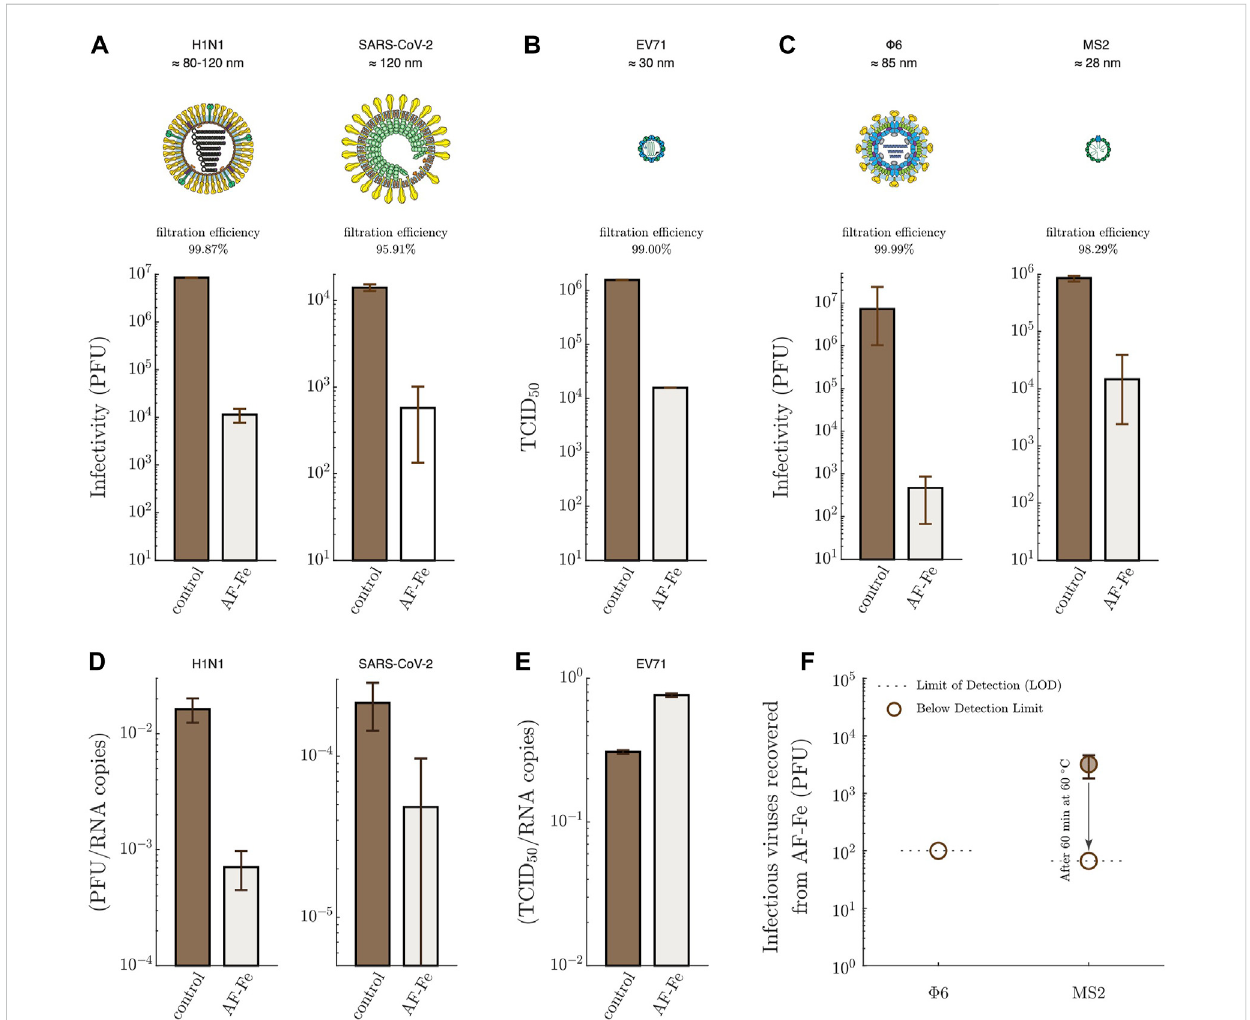
FIGURE 3 Filtration of virus-loaded aerosols using AF-Fe. Infectious viruses trapped on the gelatine membranes in the absence (control) and the presence of AF-Fe for H1N1 and SARS-CoV-2 (A) ; EV71 (B) ; Φ 6 and MS2 (C) . The plotted values for H1N1 (control and AF-Fe), SARS-CoV-2 (control and AF-Fe), EV71 (control and AF-Fe), and Φ 6 (AF-Fe) represent the average from two replicas, with the error bars representing the range. For Φ 6 (control) and MS2 (control), the plotted values represent the average from four replicas, with the error bars representing the range. For MS2 (AF-Fe), the plotted value representstheaveragefromthreereplicas,withtheerrorbarrepresentingtherange.ForH1N1,SARS-CoV-2, Φ 6,andMS2,theinfectivitywasdetermined using plaque-forming units (PFU) assays. The infectivity of EV71 was determined using median tissue culture infectious dose (TCID 50 ). The ratio of infectious viruses to RNA copies, determined using RT-qPCR, is shown for H1N1 and SARS-CoV-2 (D) , and EV71 (E) . (F) Infectious viruses recovered after incubating the AF-Fe in PBS buffer for ≈ 1 h for both Φ 6 and MS2. Representations of virions were reproduced with permission (Le Mercier,